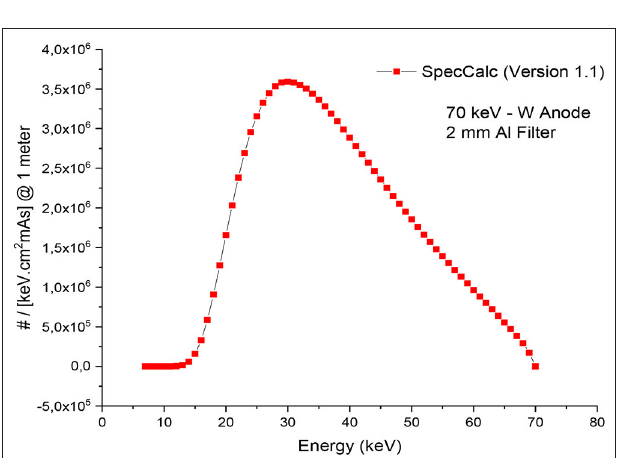
FIGURE 3 | X-ray spectrum obtained from SpecCalc ( version 1.1 ) for 70 kVp tube voltage and 2mm Al Filter.